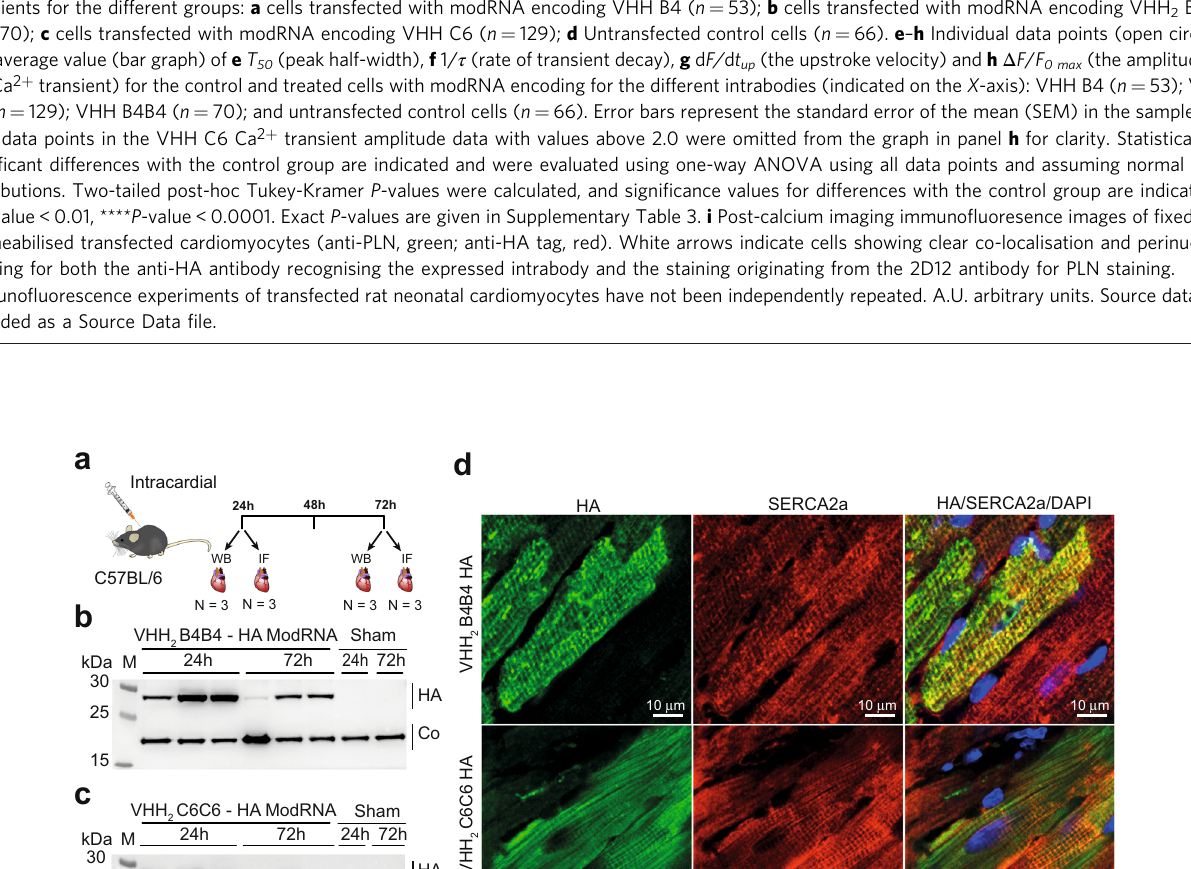
Fig. 4 In vivo expression and tissue distribution of intramyocardial injected modRNA of the intrabodies VHH 2 B4B4-HA and VHH 2 C6C6-HA. a Overview of the experimental procedure: Mice ( n = 12) were injected intramyocardially with modRNA, sacri fi ced after 24 or 72 h; hearts were collected for western blot analysis ( n = 3 at 24 h, n = 3 at 72 h); and immuno fl uorescence imaging (IF) of tissue sections ( n = 3 at 24 h, n = 3 at 72 h). 6 mice, not treated with modRNA were used as control samples: western blot ( n = 2 at 24 h; n = 2 at 72 h) and IF ( n = 1 at 24 h; n = 1 at 72 h) b , c Western blot analysis of whole heart lysates (VHH 2 B4B4: n = 3 at 24 h, n = 3 at 72 h; VHH 2 C6C6-HA: n = 3 at 24 h, n = 3 at 72 h; control: n = 1 at 24 h, n = 1 at 72 h). The membranes were stained with anti-HA to reveal the expression of the HA tagged intrabodies: b VHH 2 B4B4-HA, c VHH 2 C6C6-HA. An anti-co fi lin antibody was used as a loading control. Lane 1 contains a molecular weight marker (M) and sizes of the bands (in kDa) are indicated on the left. Western blots were performed n = 3 times with similar results. d Immuno fl uorescence imaging of transfected mouse hearts after 24h of in vivo expression of VHH 2 B4B4-HA (top panels) and VHH 2 C6C6-HA (bottom panels). Slices were stained with DAPI, the SERCA2a antibody (red) and the anti-HA antibody (green). Identical immuno fl uorescence staining was repeated twice for tissue sections of mice transfected with VHH 2 B4B4-HA at the 24 h time point and repeated once for tissue sections of mice transfected with VHH 2 C6C6-HA at the 24 h time point (using 10 slices per heart) and resulted in similar staining patterns. Source data are provided as a Source Data fi le.